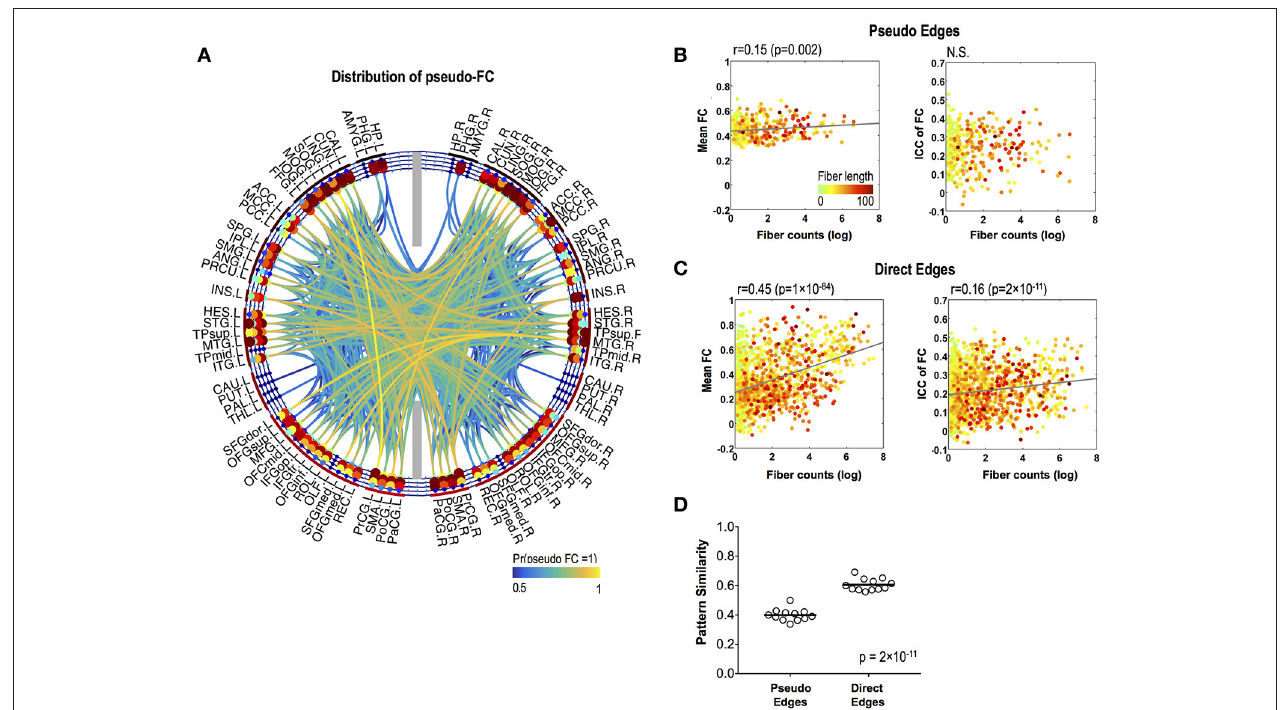
FIGURE 4 | Stability of pseudo-FC. (A) The spatial distribution of pseudo-FC. The relationships between the mean functional connectivity of FC and log-transformed fiber counts (left) and between the stability (ICC) of FC and log-transformed fiber counts (right) for pseudo edges (B) and direct edges (C). (D) Pattern similarity of FC within a subnetwork of pseudo functional edges and within a subnetwork of direct functional edges. The dots in (B,C) are colored according to the fiber lengths where we set greater than 100 to 100 mm for effective color-coding since such connections were very rare in our